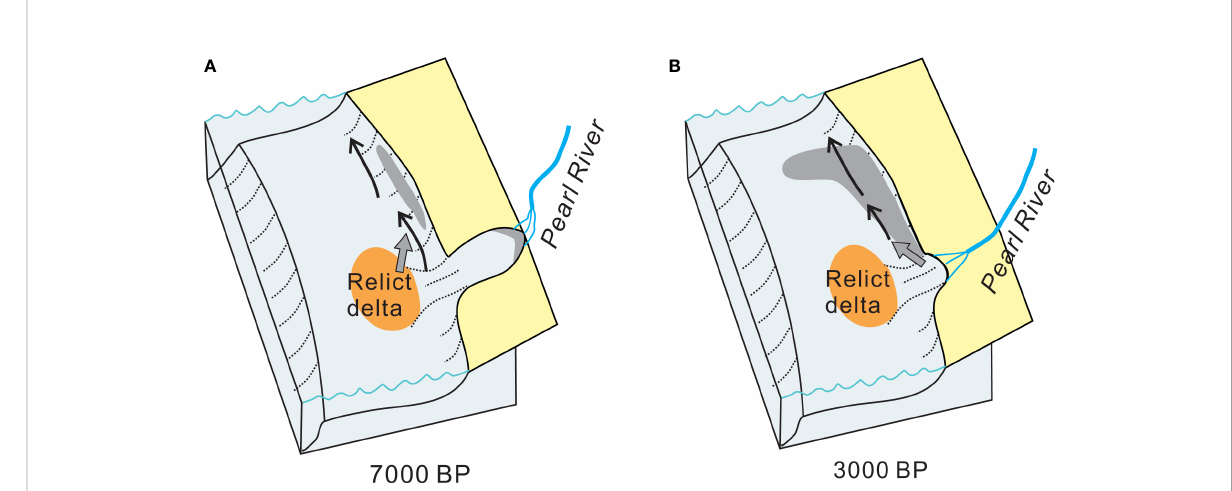
FIGURE 9 Schematic diagrams show the con fi gurations of shelf muddy sedimentation in north-western South China Sea. (A) small muddy wedges have been present in shallow waters since 7 ka BP which were fed by reworked sediments from the relict delta of Pearl River. (B) wide-spread muddy zones on the middle shelf initiated after 3 ka BP when the paleo-embayment has been fi